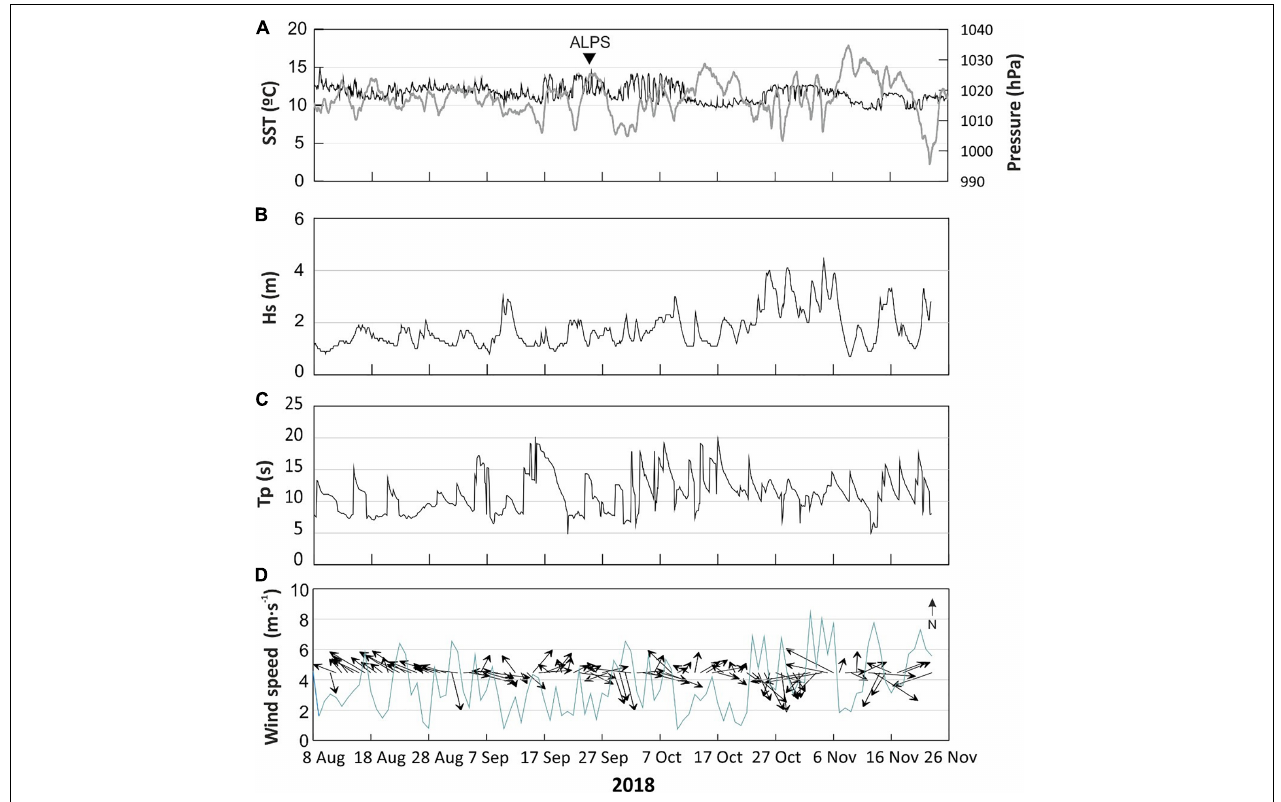
FIGURE 3 | Time series of meteorological (wave and wind) conditions measured by the NOAA WW3 model during the study period, spanning from the 14th of August to the 23rd of November 2018. Atmospheric conditions are based on (A) sea surface temperature (SST, ◦ C) (black line) and sea level atmospheric pressure (hPa) (gray line). The presence of the Aleutian low-pressure system (ALPS), which intensified during fall months over the region, is indicated with a black triangle. Wave conditions are (B) significant wave height ( Hs , m), and (C) primary wave period ( Tp , s). Wind parameters are (D) speed and direction. Wind speed is represented by a light blue line, whereas wind direction is represented by the black arrows. For interpretation of the references to color in this figure legend, the reader is referred to the web version of this article.